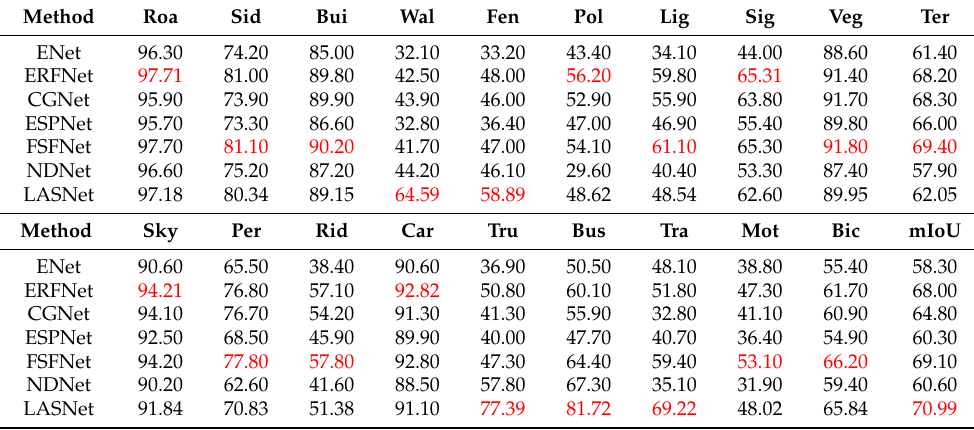
Table 3. Compared with other approaches on the CityScapes in terms of per-class results. The red color font indicates the optimal